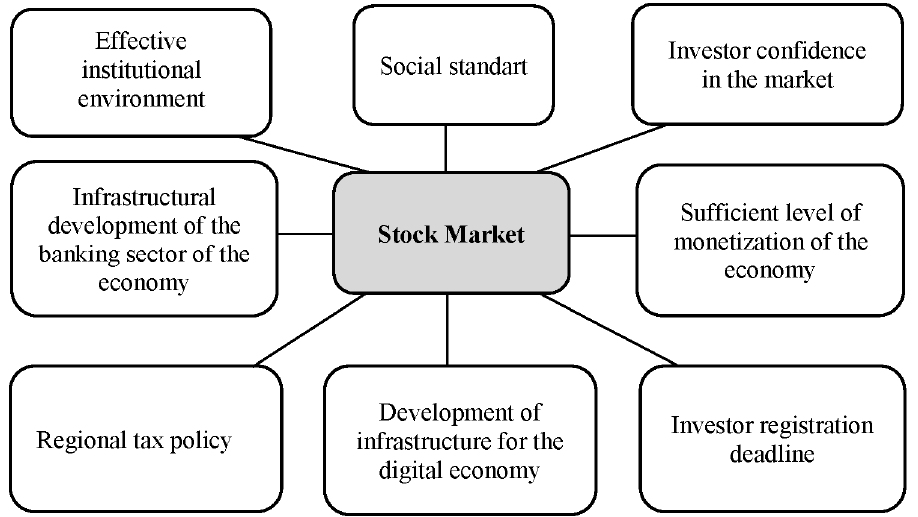
Figure 7. Internal factors influencing the Brazilian stock market. Formed by the authors on the basis of Ademir et al. 2012.